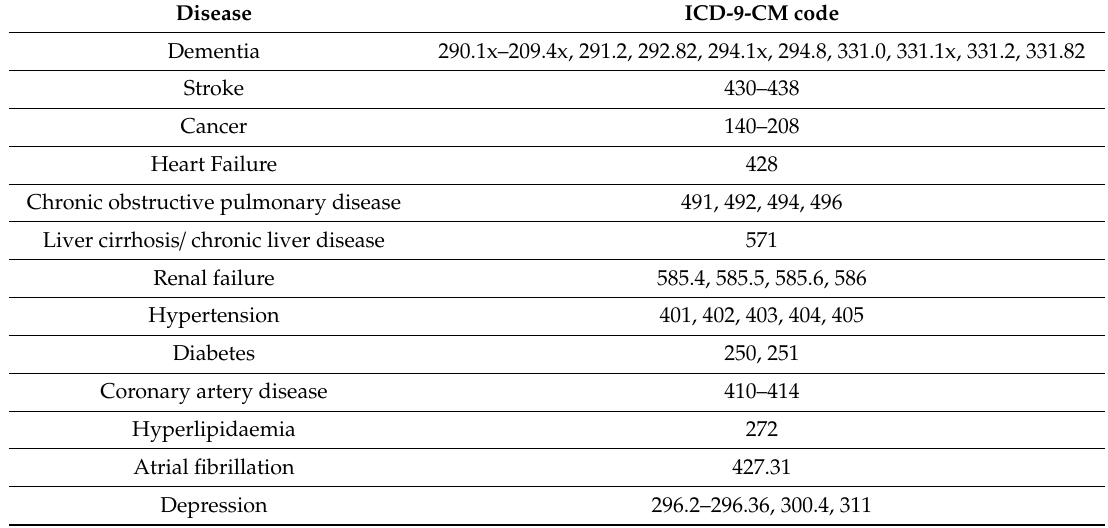
Table A1. List of International Classification of Diseases, Ninth Revision, Clinical Modification (ICD-9-CM) code of the diseases.